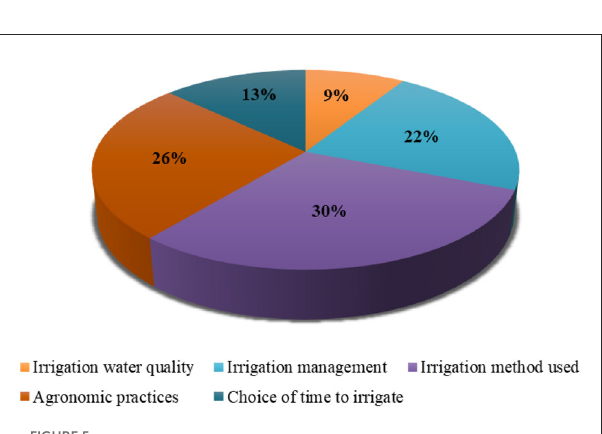
FIGURE5 Sustainable irrigation innovations adopted by the sample of farms surveyed*. *Our